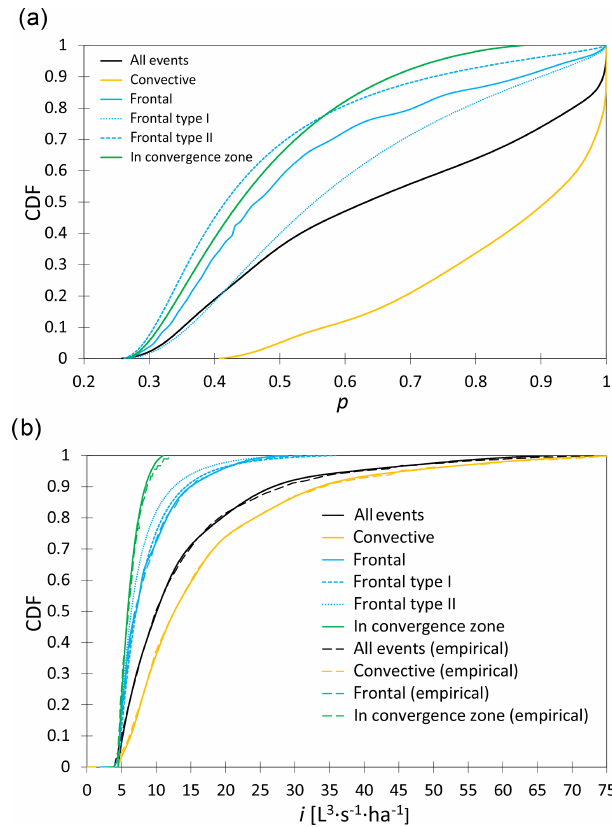
Figure 8. Impact of rainfall genesis on (a) the probability of storm overflow and (b) rainfall intensity distribution determining storm